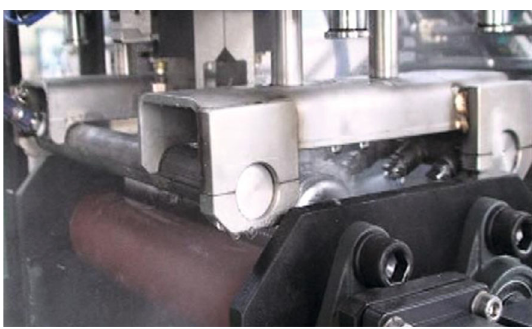
Figure 15: Operating test to validate the clamp load.